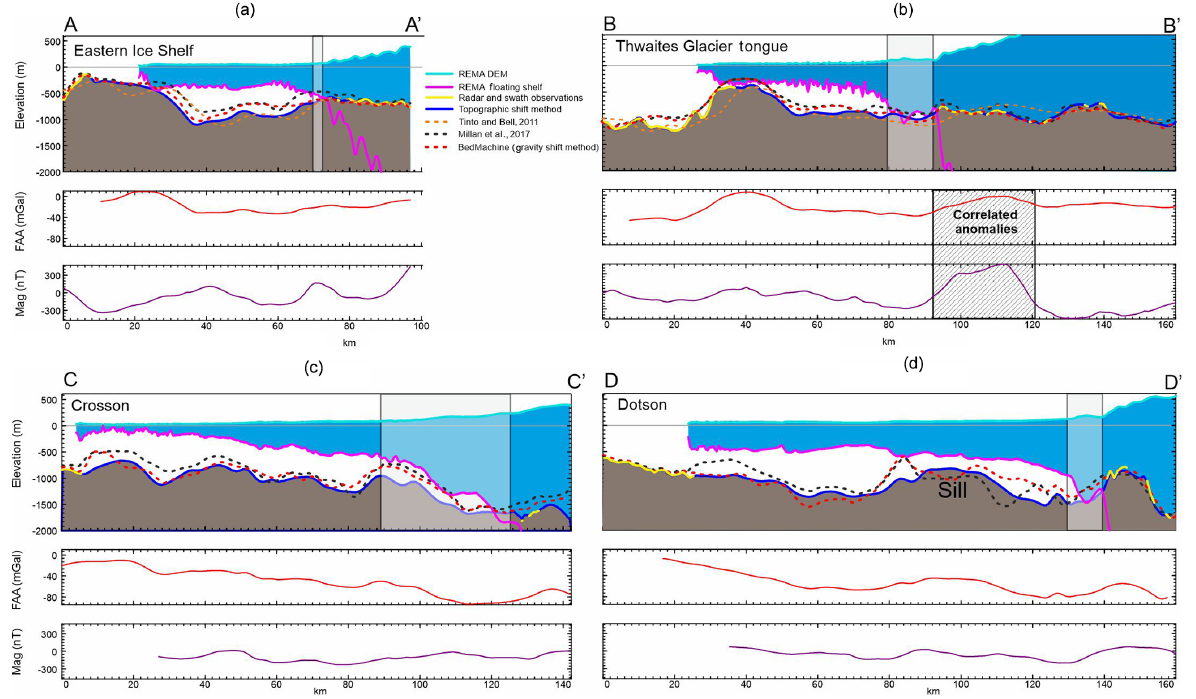
Figure 3. Profiles across ice shelves. For each panel the upper part shows the ice surface from REMA DEM (Howat et al., 2019) and the base of ice shelf calculated assuming hydrostatic equilibrium, together with gravity-derived bathymetric estimates. The central part of each panel shows the input free-air gravity anomaly. The lower part of each panel shows magnetic anomalies derived from ITGC survey data (Jordan et al., 2020b) and ADMAP2 (Golynsky et al., 2018). The data are taken from (a) Thwaites Eastern Ice Shelf, (b) Thwaites Glacier tongue, (c) Crosson Ice Shelf, and (d) Dotson Ice Shelf. Note the thin cavity in regions of ice sheet grounding line retreat since 1993 (grey boxes in the upper panels). Additionally, in (d) note the > 500m bathymetric highs in BedMachine (Morlighem et al., 2020) and Millan et al. (2017) profiles not associated with a free-air gravity anomaly, indicative of artefacts resulting from the inversion